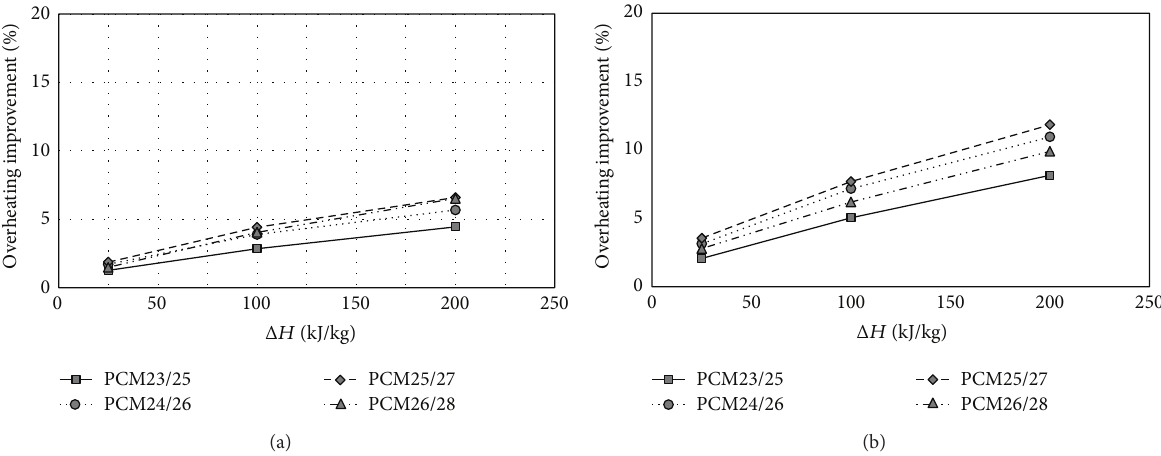
Figure 6: Discomfort analysis due to overheating inside an office cell placed in (a) Lisbon and (b) Porto.